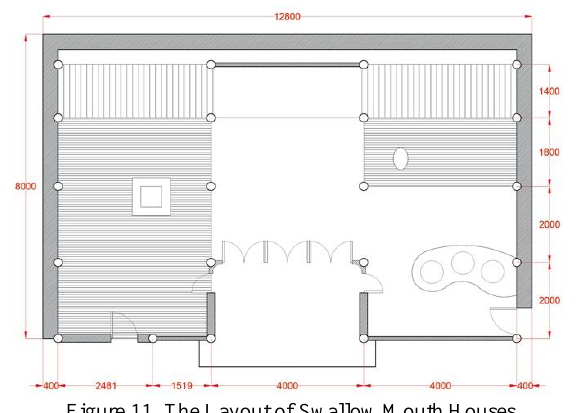
Figure 11. The Layout of Swallow Mouth Houses.